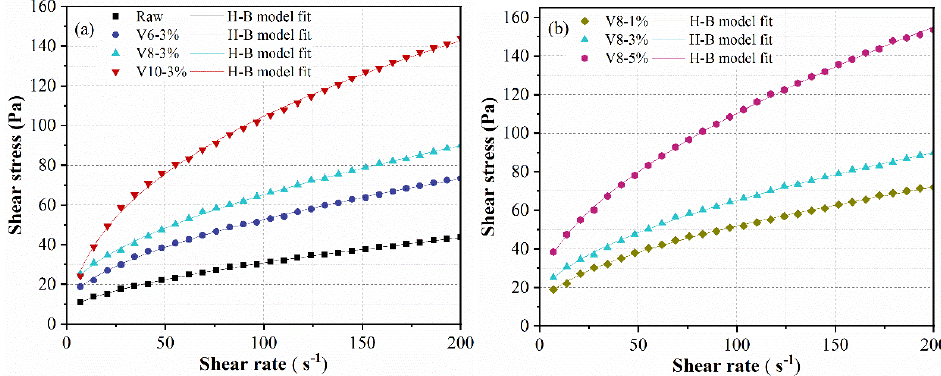
Figure 4. Shear stress (down-ramp) of BFS-SS-based AAMs: effect of BFS fineness ( a ) and effect of NC dosage ( b ). Table 3. Rheological parameters of the fresh pastes by H-B